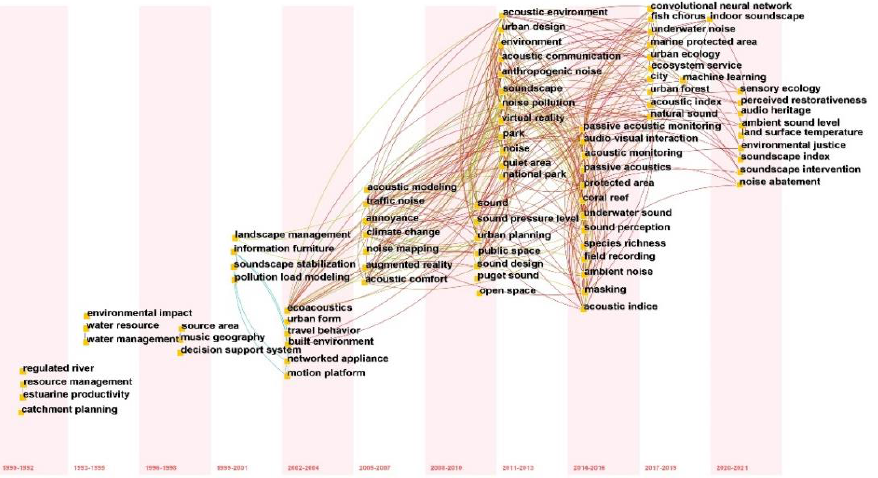
Figure 9. Keywords time zone diagram (timeline view) in soundscape research.